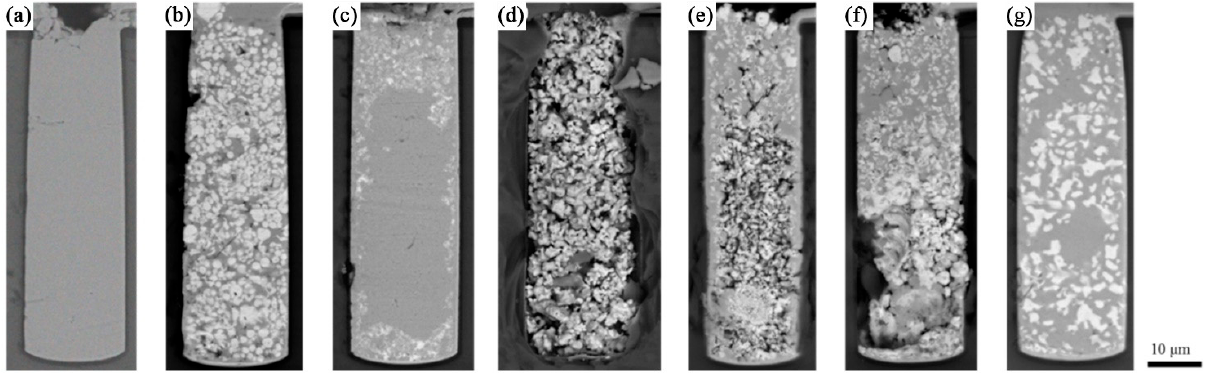
Figure 2. Cross-section of microvias: ( a ) sample #1, ( b ) sample #2, ( c ) sample #3, ( d ) particles sintered in microvia, ( e ) sample #4-1, ( f ) sample #4-2, ( g ) sample